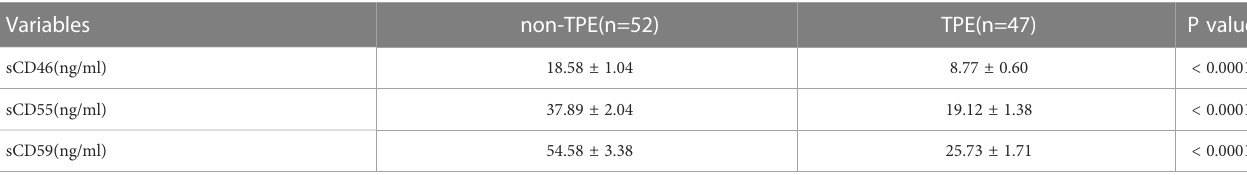
Data are shown as median (interquartile range mean ± standard deviation).